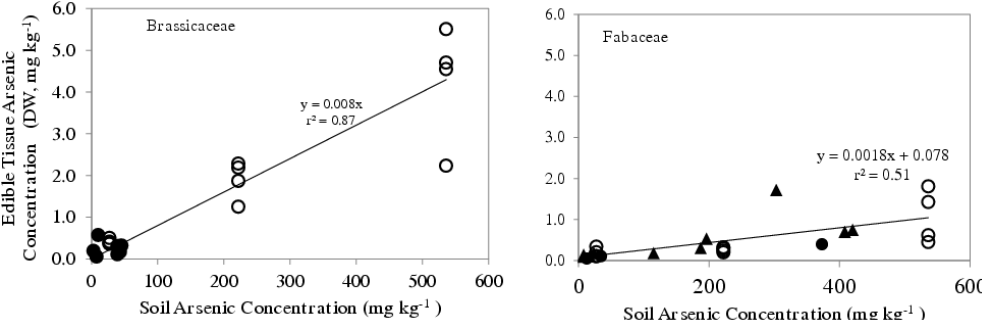
Figure 4. Arsenic concentration in the edible portion of Brassicaceae ( left , no border cell production) and Fabaceae ( right , 3000–4000 border cells produced per root per day) as a function of soil arsenic concentration. Values were compiled from reference [52]. Open symbols ( ○ ) represent vegetables grown in the greenhouse, closed symbols ( ● ) represent vegetables grown in home gardens, and the closed triangles ( ▲ ) represent values from the literature.